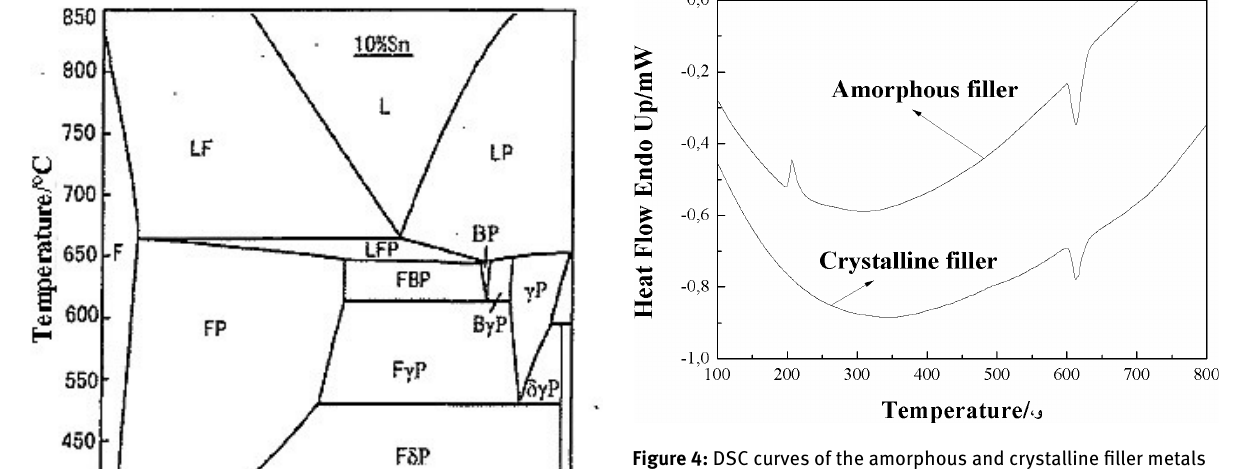
ogy. However, the internal structure of crystalline filler metal is in a stable state, and therefore no significant changes were observed by optical microscopy during the heating process (Figure